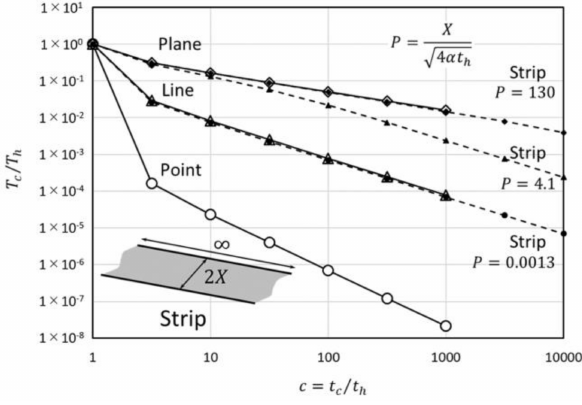
Figure 6. Temperature-decreasing ratio of the strip heat source.